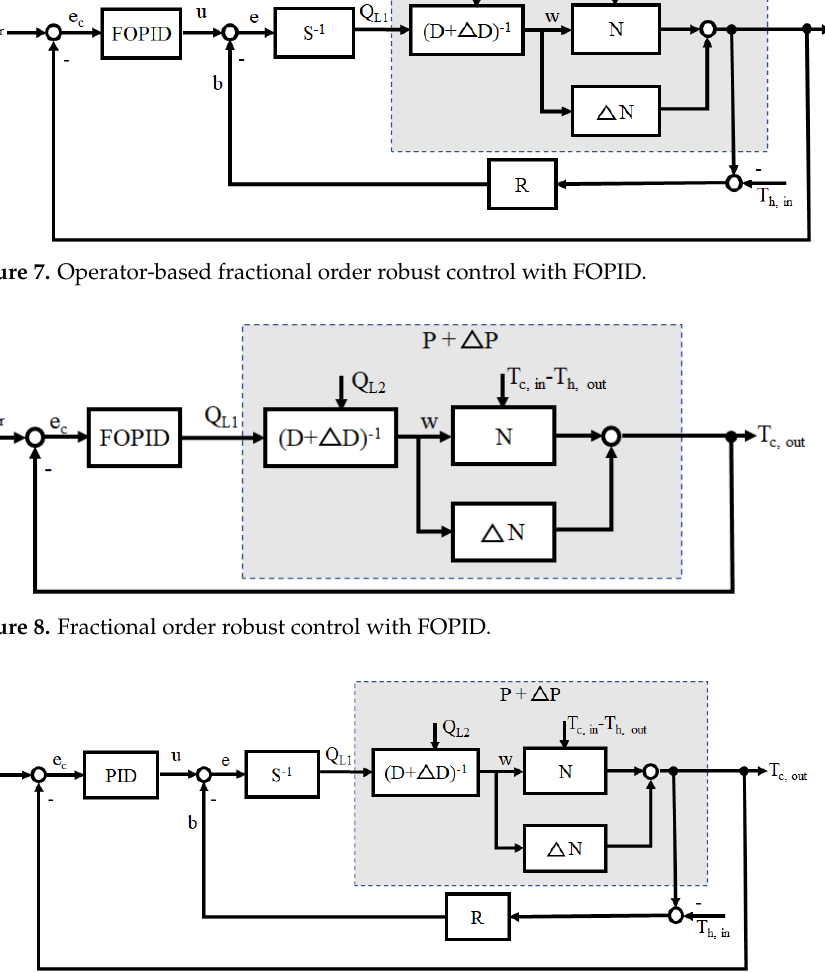
Figure 9. Operator-based fractional order robust control with